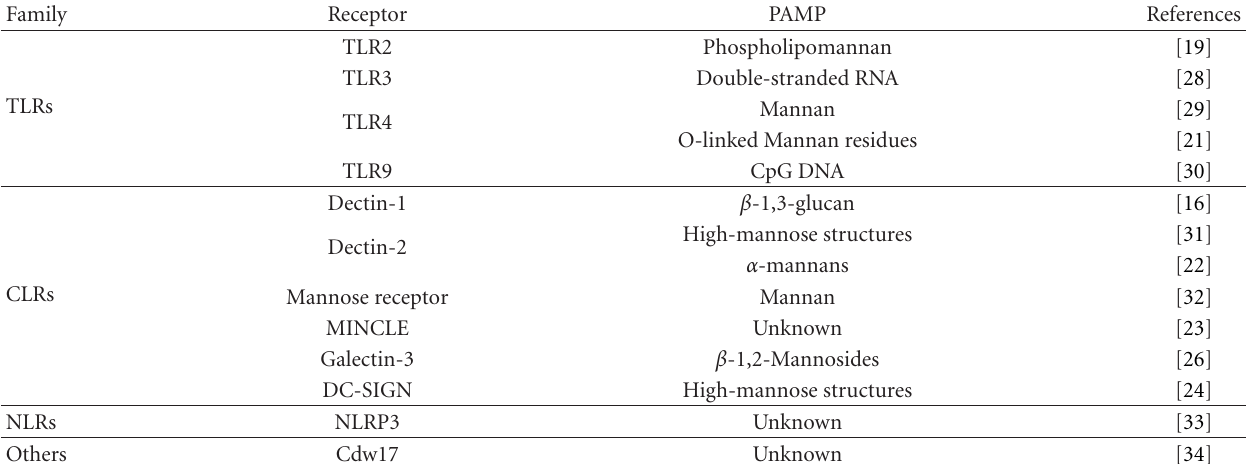
Table 1: Pattern recognition receptors that sense fungal-associated